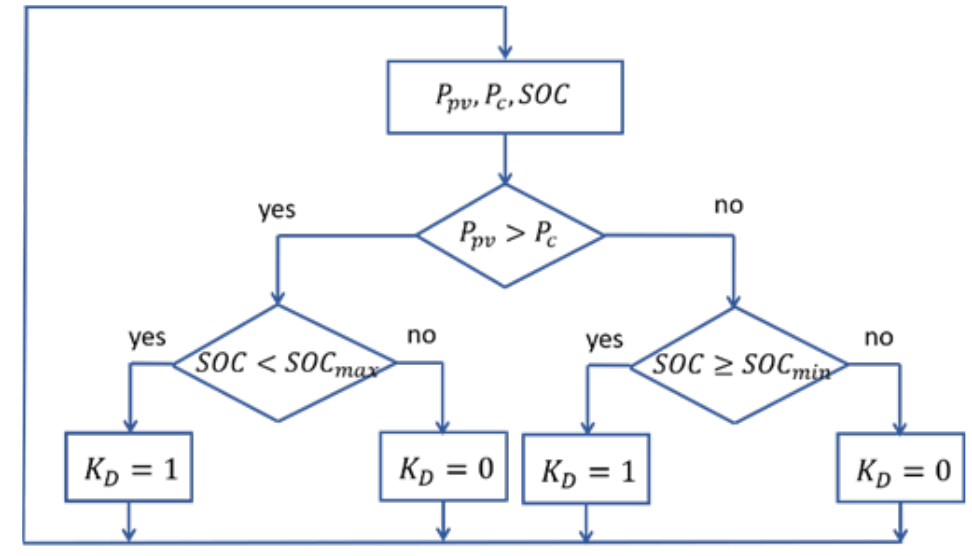
Figure 7. Flowchart of classic management of microgrid.